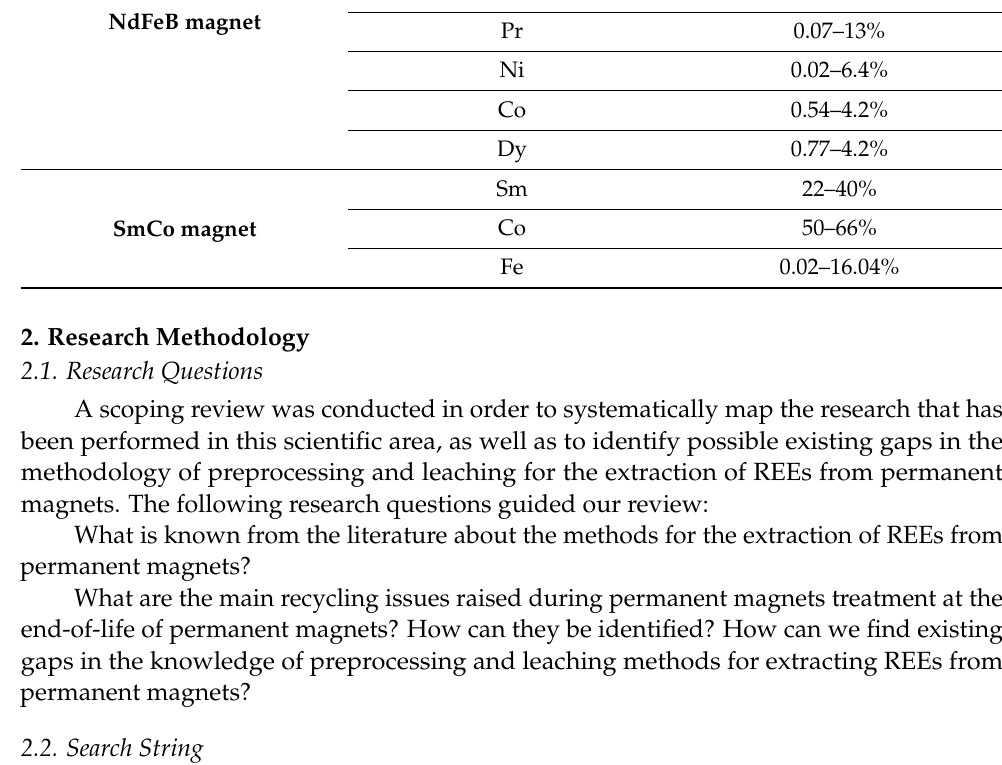
Table 1. Typical chemical composition of Nd and Sm permanent magnets [29–34]. Type of Magnet Element Range Nd 22–31% Fe NdFeB magnet